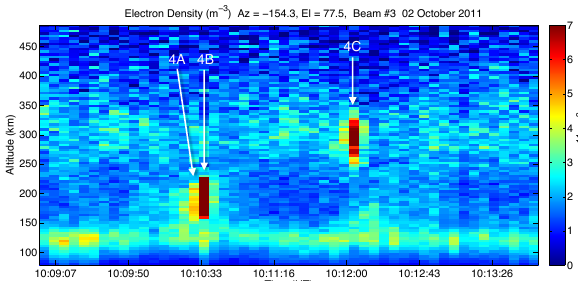
Figure 12. Event 4: PFISR electron density profiles, covering a time period of about 5min with structured pulsating aurora in zenith. The strong NEIAL returns can be seen at two times and at different alti- tude ranges. The times marked 4A–4C are the times of the NEIAL spectra shown in Fig.